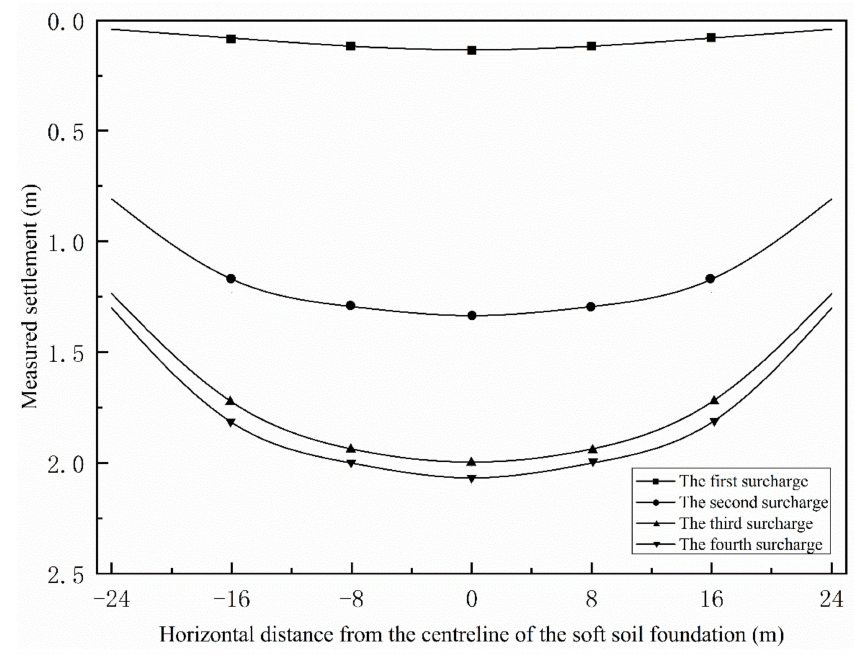
Figure 11. Measured results under the four